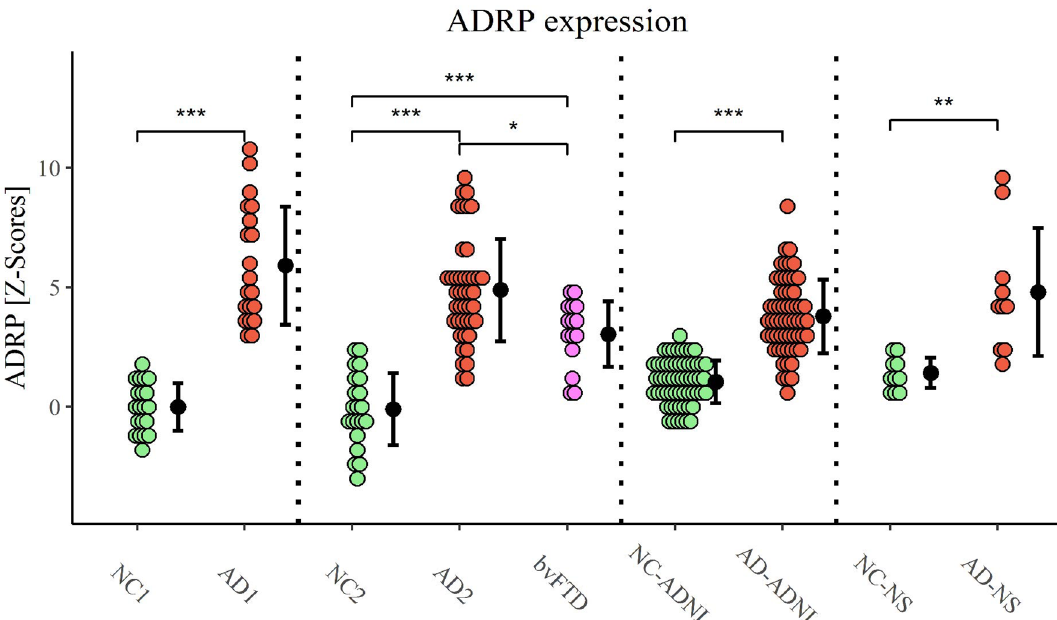
Figure 2. Alzheimer’s disease-related pattern expression. Data are Z-scored based on the pattern expression in NC1 group. Means (SD) are presented to the right of individual data. NC1 normal control identification group, AD1 Alzheimer’s dementia identification group, NC2 NC validation group, AD2 AD validation group, bvFTD behavioral variant of frontotemporal dementia, ADNI Alzheimer’s Disease Neuroimaging Initiative, NS Northshore, ADRP Alzheimer’s disease-related pattern. * p < 0.01, ** p < 0.001, *** p <